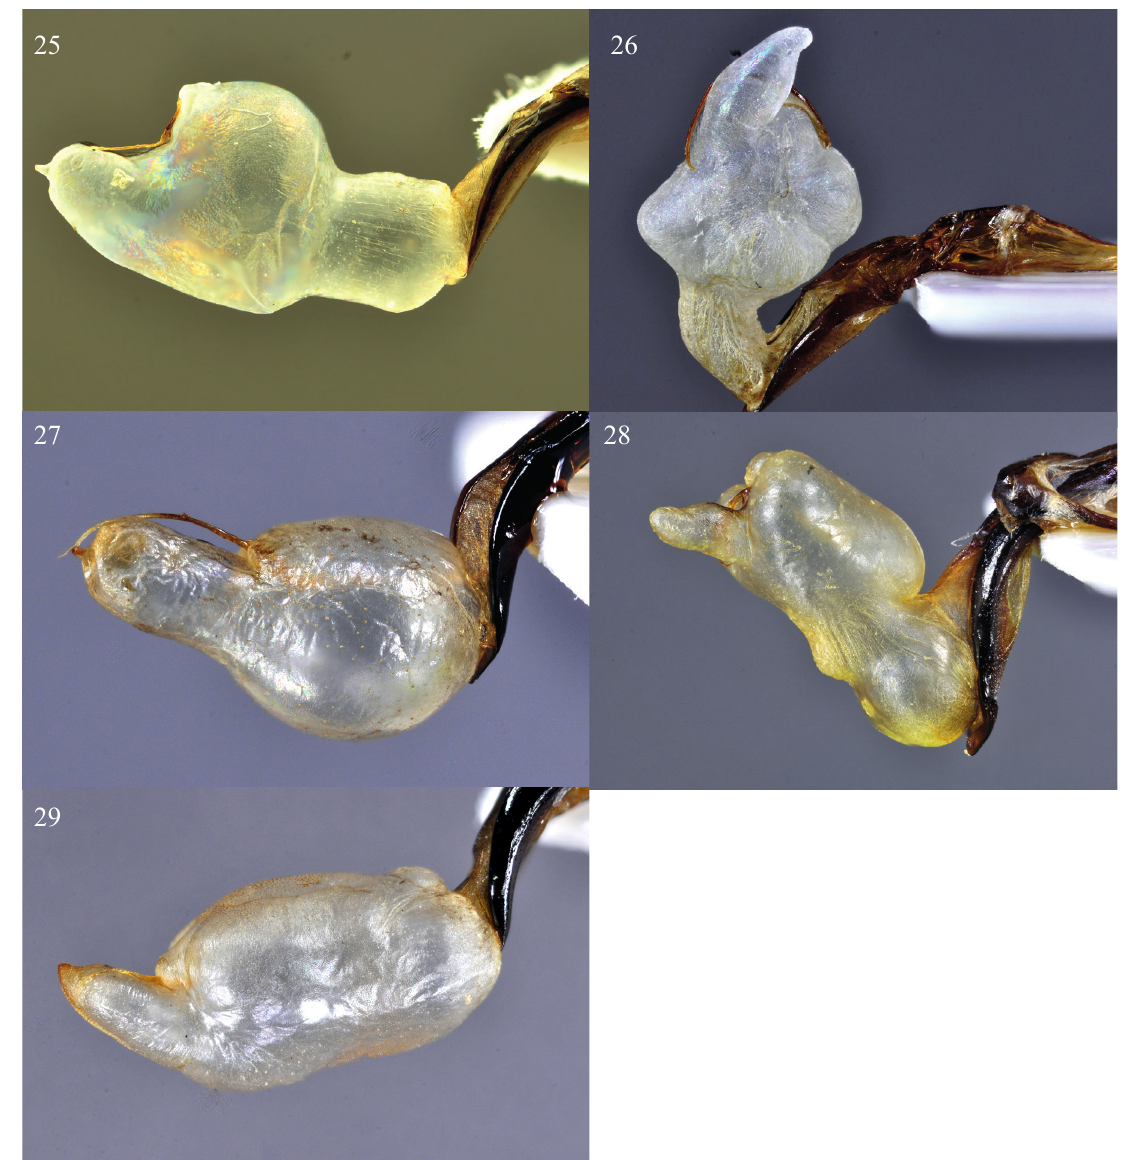
Figs 25–29. Air inflated endophallus. 25 . Timarcha goettingensis (Germany, Bad Frankenhausen). 26 . T. intermedia (Spain, Almería, Níjar). 27 . T. granadensis (Spain, Granada, Puebla de Don Fadrique). 28 . T. marginicollis (Spain, Granada). 29 . T. strangulata (Spain, Pyrenees). Not at the